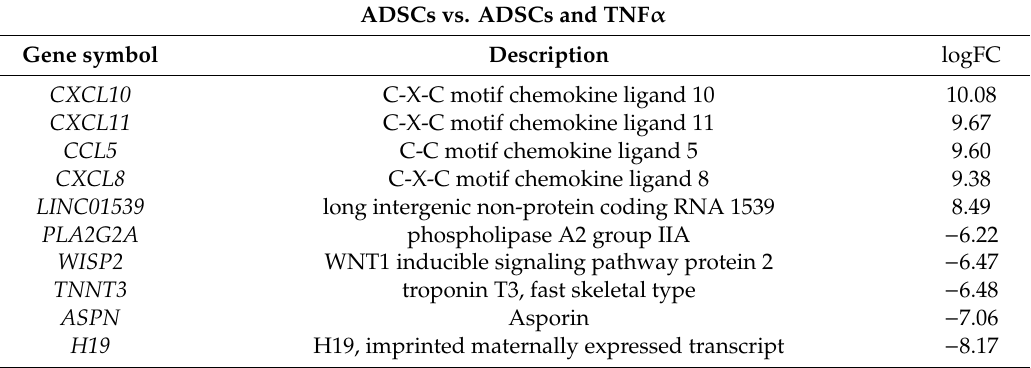
Table 1. Five most TNF α -dependent upregulated and downregulated in ADSCs and L-WAT; logFC: logarithmic